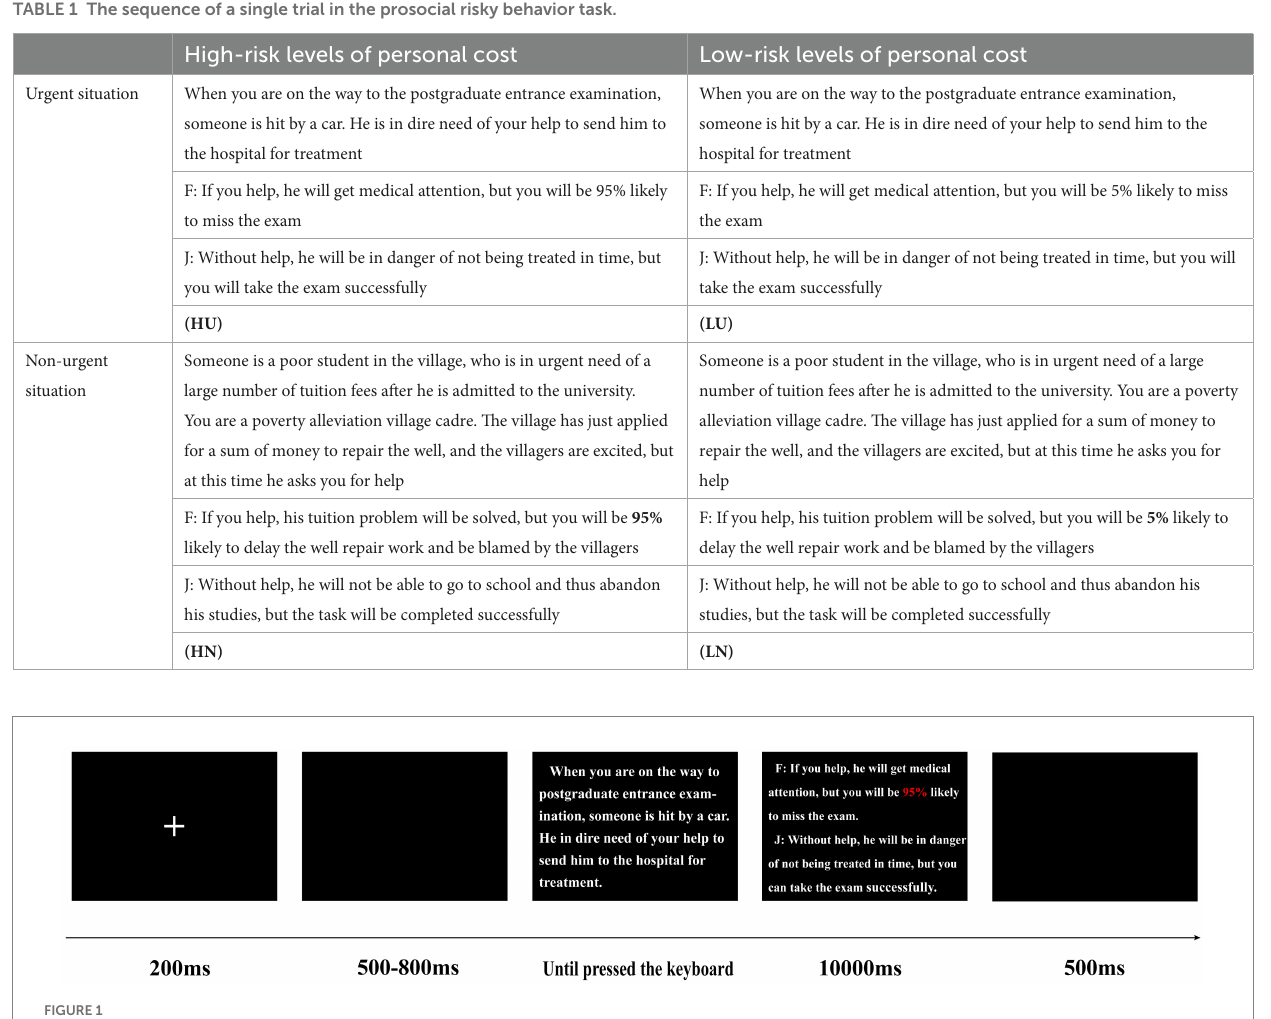
FIGURE 1 The sequence of a single trial in the prosocial risky behavior task.